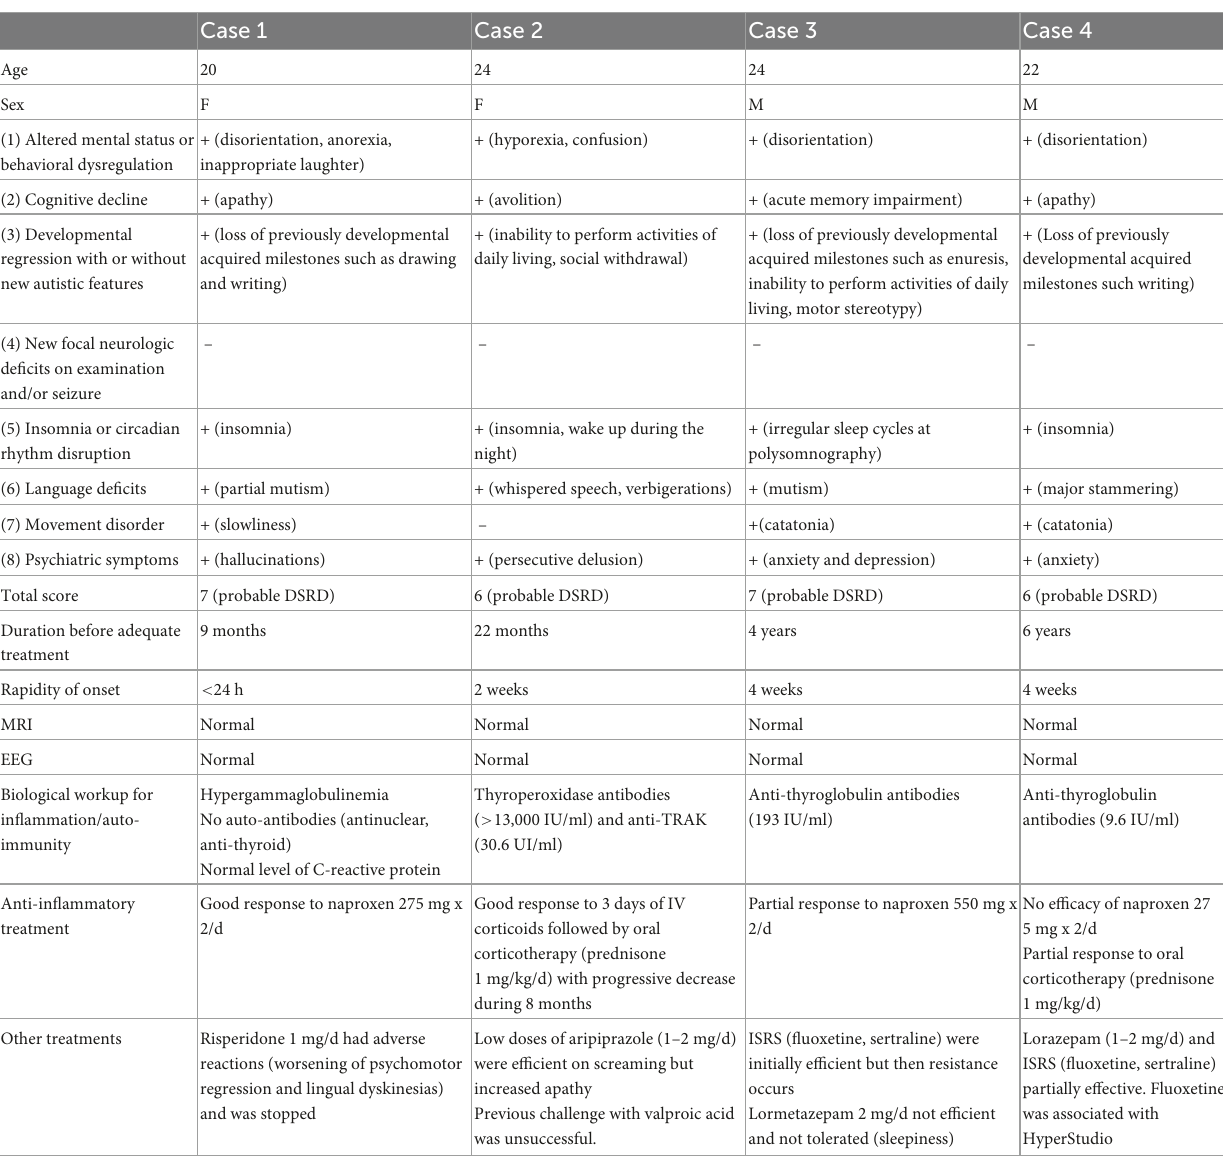
TABLE 1 Description of the four cases: age, sex, clinical criteria and score for DSRD according to the expert consensus, paraclinical workup, treatments (+: presence; − :